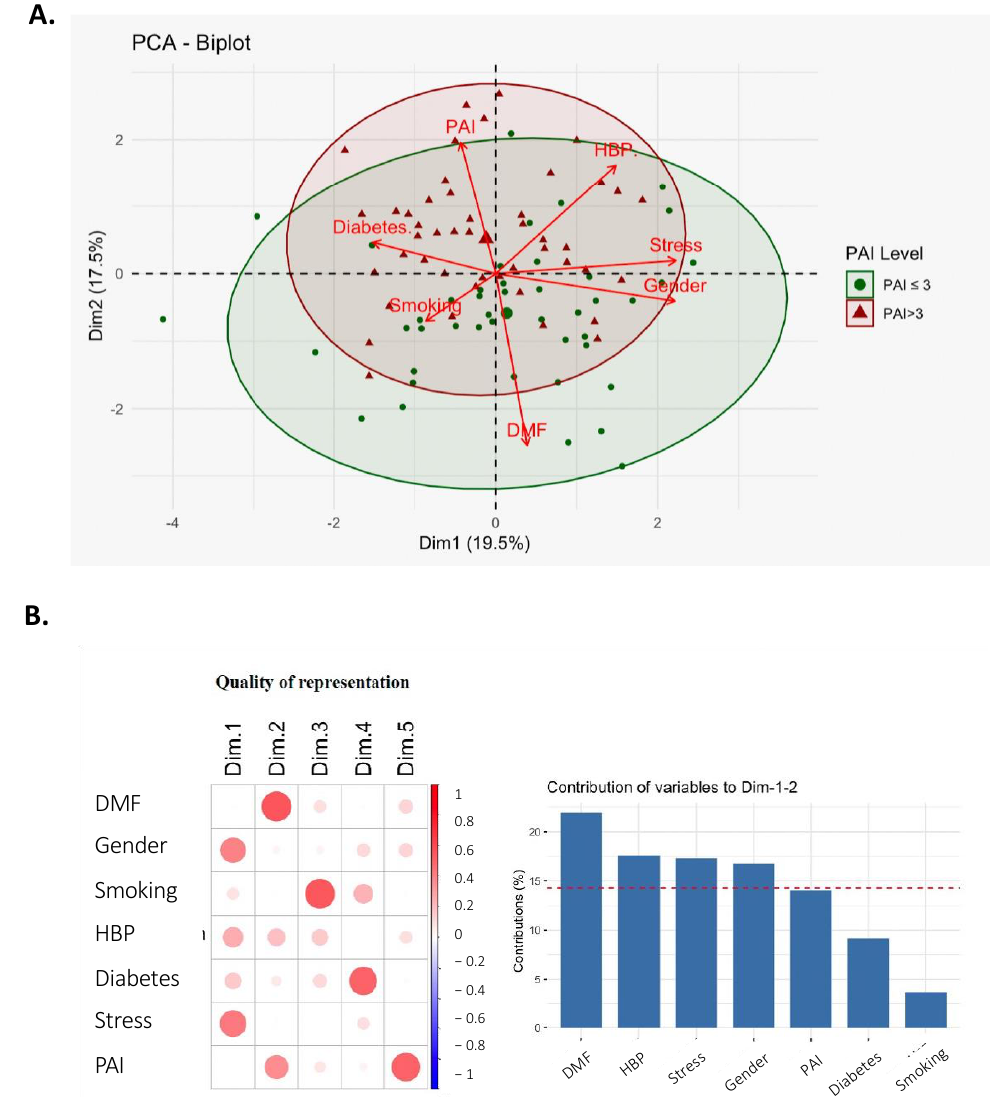
Figure 1. A principal component analysis (PCA) was generated predicting that the main systemic clinical factor responsible for the dispersion of subjects was high blood pressure (HBP). ( A ) PCA between the severity of apical periodontitis (AP) (following the PAI scores), and oral and systemic clinical parameters. ( B ) The statistical analysis for the contribution of each oral and systemic parameter for each dimension.